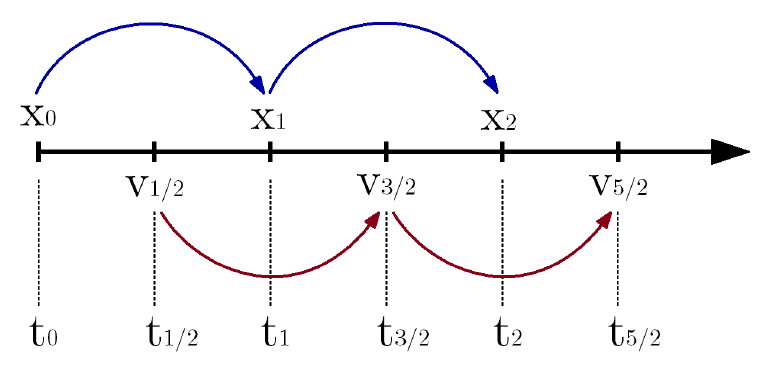
Figure 1. Schematics describing how the leapfrog algorithm works. Position and velocity leap each other, one time and another until reaching the predefined simulation steps. The position, velocity and time are symbolized by x , v and t , where the sub-indexes represent the